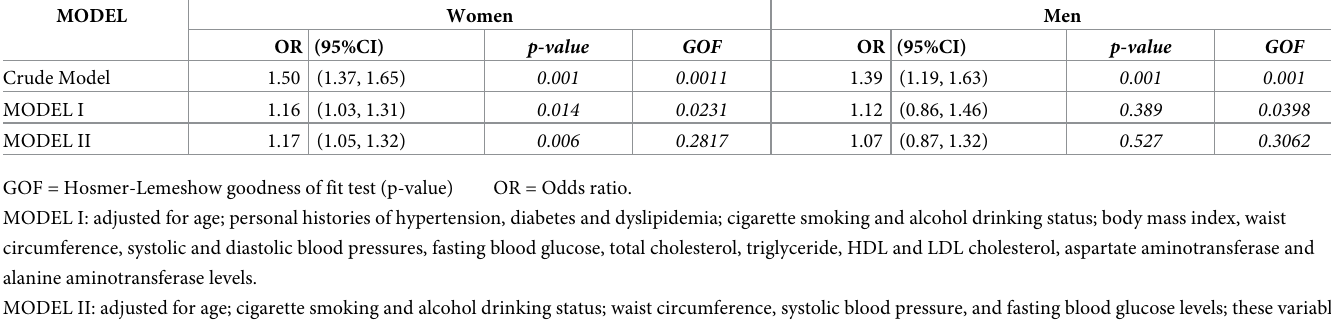
Table 3. Association between neck circumference and NAFLD, stratified by gender. MODEL